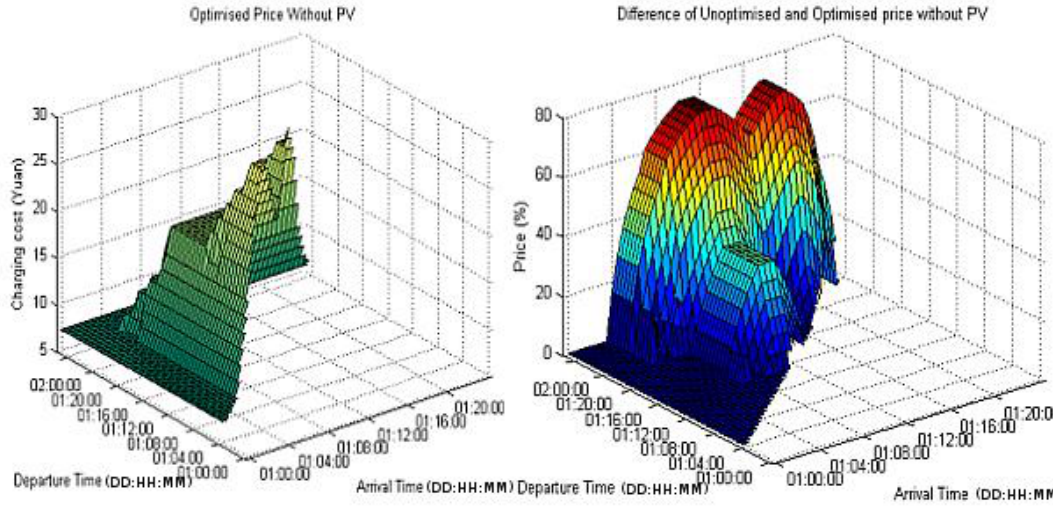
Figure 14: Optimised price without PV for Beijing Data and Percentage difference of non-optimised price for Beijing TOU